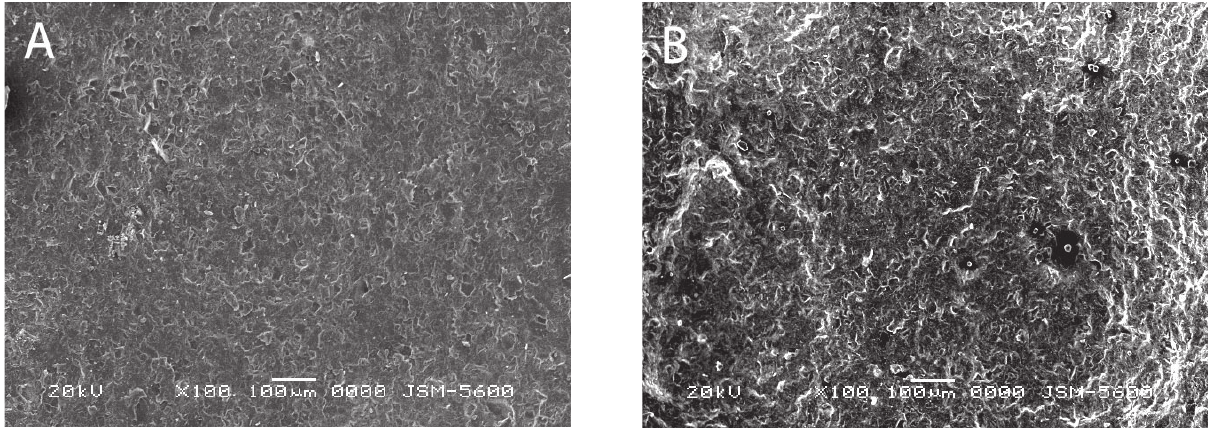
Figure 2- A, Scanning electron microscope (SEM) image (original magnification x100) of the surface of a ceramic bracket airborne- particle abraded with 50-µm Al